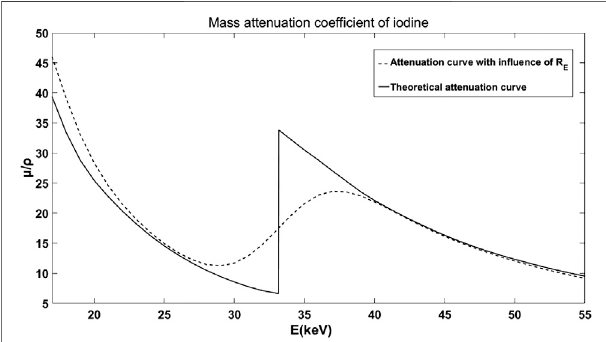
FIGURE 2 | The theoretical mass attenuation curve and the curve with the in fl uence of R E . Thesolid lineisthe masstheoreticalattenuationcurve and the dashed lineis the result ofthe mass attenuation curve with the in fl uence of R E